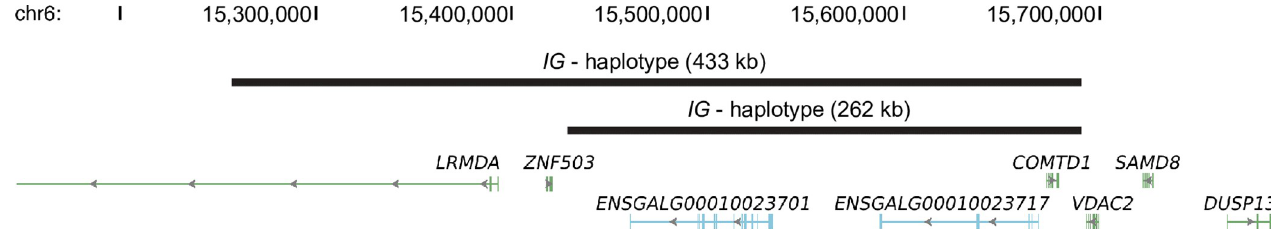
Fig 3. Gene content of the IG interval. The annotation is based on the chicken genome assembly as presented on the UCSC sequence browser. Both the larger (433 kb) and the smaller (262 kb) IBD regions associated with the IG allele are marked.